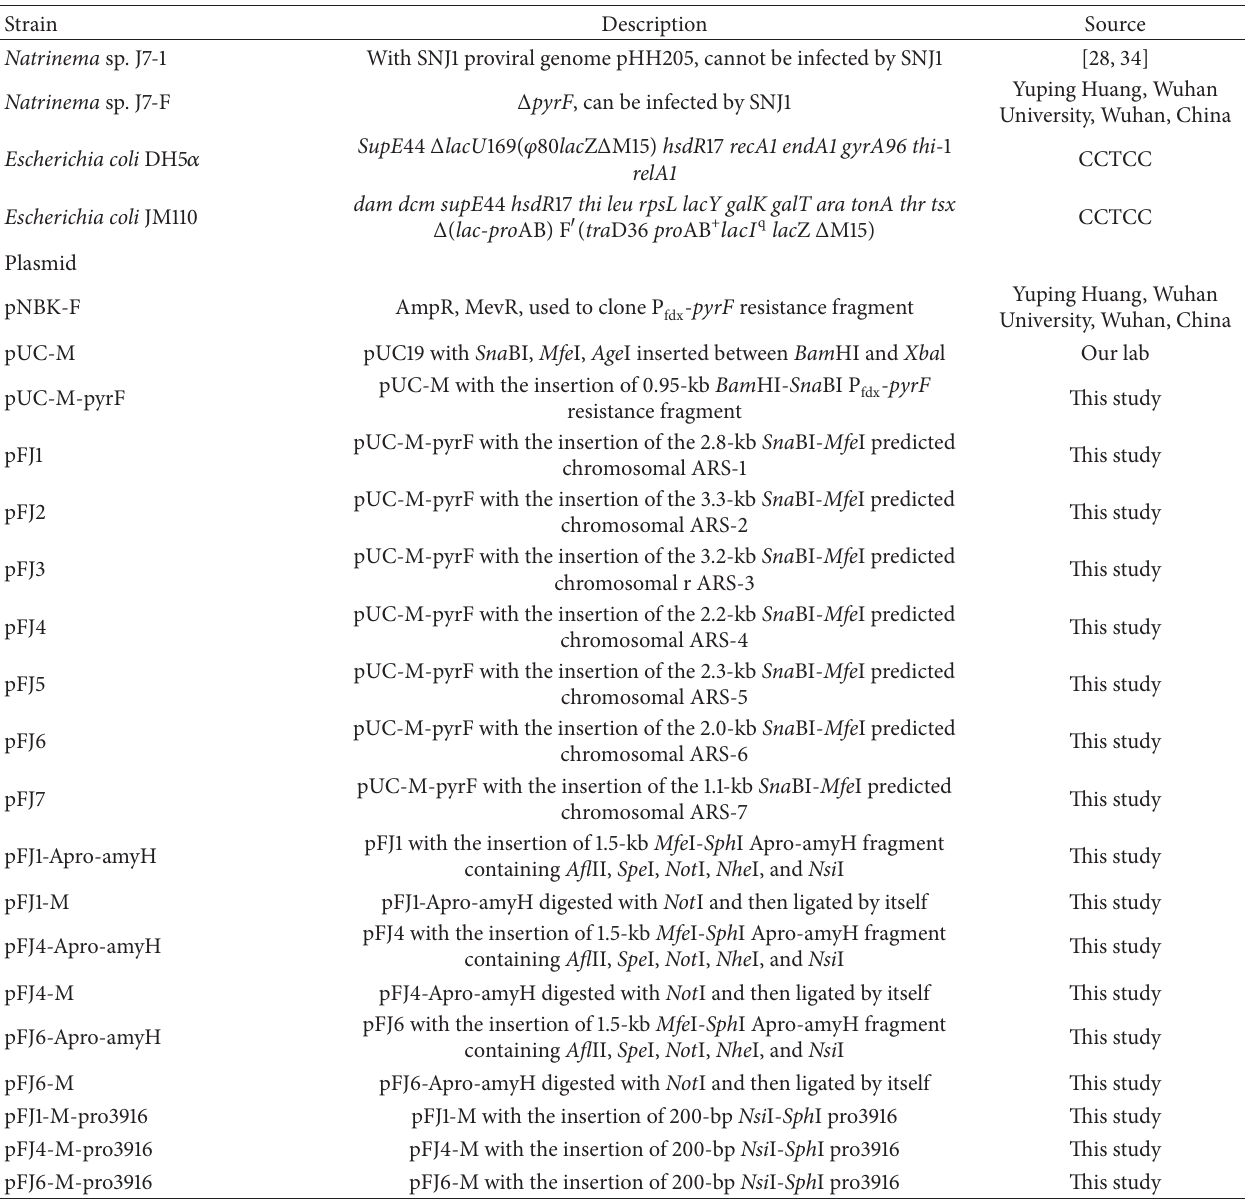
Table 1: Strains and plasmids used in this